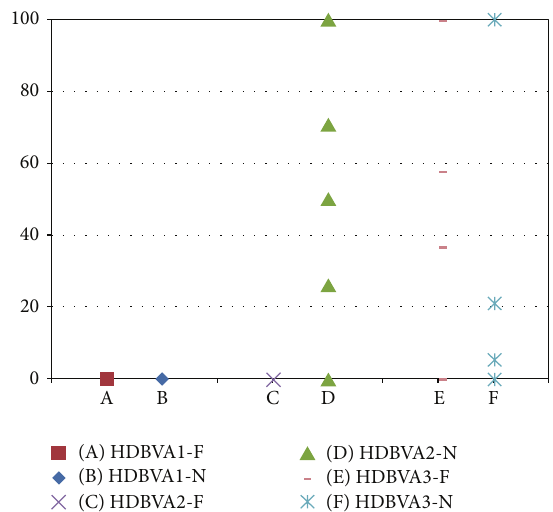
Figure 13: In-range slider displacement percentages of case Figure 10(c).